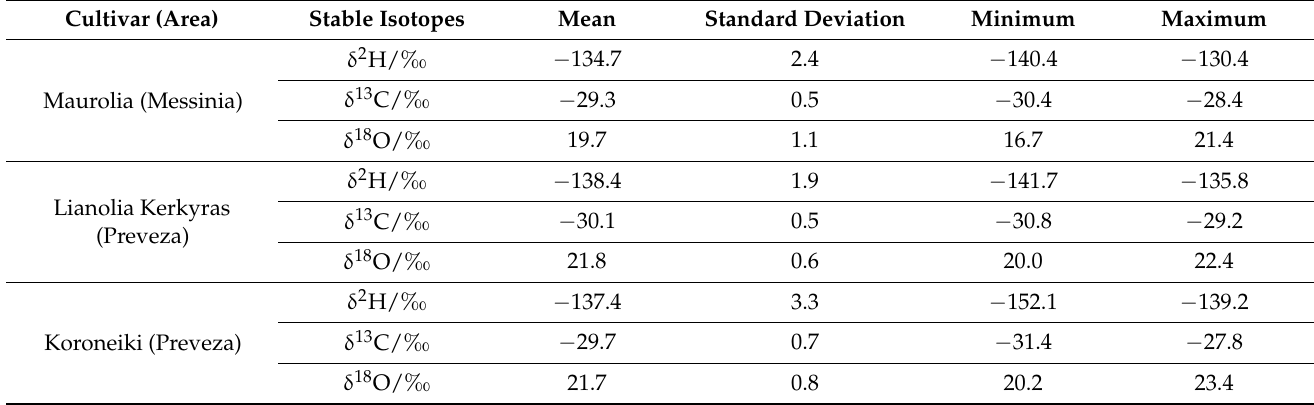
Table 2. Stable isotope ratios ( 13 C/ 12 C, 2 H/ 1 H, 18 O/ 16 O) of Greek olive oils from three monocultivars, i.e., Maurolia (Messinia), Lianolia Kerkyras (Preveza), and Koroneiki (Preveza), thus from two geographic areas, i.e., Messinia and Preveza. Cultivar